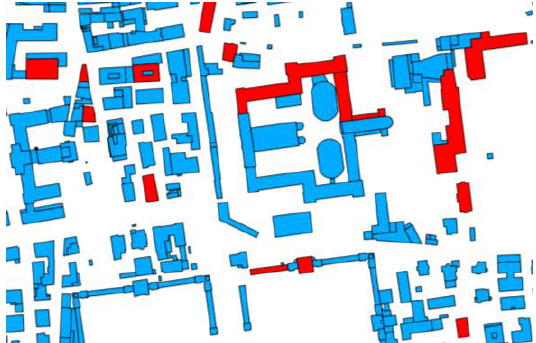
Figure 5. Test area and surveyed buildings for 3D model-ground truth comparison.